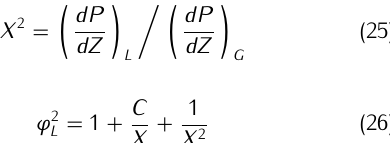
Also plotted in Figure 14 is the curve obtained for a C value of 0.24, as was measured experimentally by Kawa- hara et al. [8]. That curve predicts considerably lower val- ues of the two-phase frictional multiplier. Therefore, the two-phase frictional pressure drop measured by Kawahara et al. [8] was lower than the values presently obtained from the numerical simulation. In fact, over the range of X val- ues tested in the present runs (approximately 5 to 15), the data of [8] indicated values of φ 2 very close to 1.0, mean- L ing that the measured two-phase frictional pressure drop is virtually equal to the single-phase liquid pressure